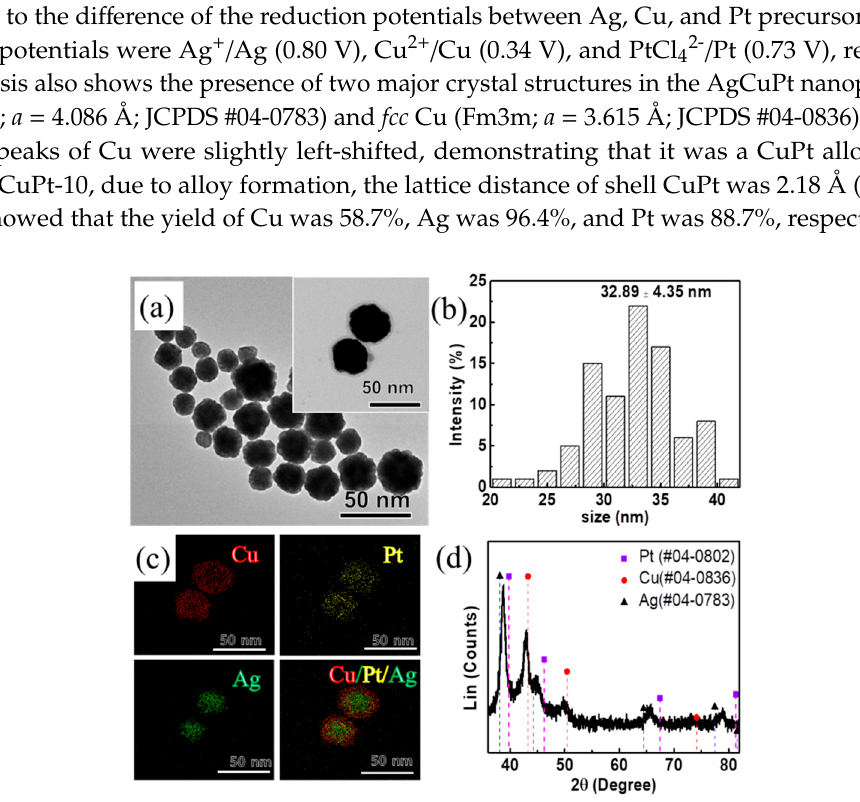
Figure 4. ( a ) TEM image, ( b ) size distribution, ( c ) energy-dispersive X-ray spectroscopy (EDS) mapping images, and ( d ) XRD patterns of metallic elements distribution in as-prepared CuAgPt nanoparticles (red refers to Cu, yellow refers to Pt, and green refers to